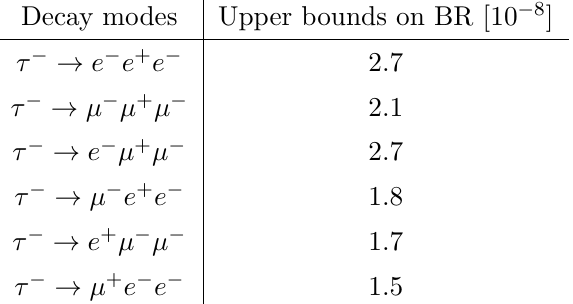
figure 4. For the kinematically allowed mass range, the constraints on BR ( τ → Xl about 1 . 4 × 10 − 4 for Scenario 1 and 2 . 6 × 10 − 3 for the second scenario. The corresponding upper limits on g are as strong as about 4 × 10 − 8 GeV − 1 and 2 × 10 − 7 GeV − 1 for the two τα scenarios, respectively, at the low mass regime. After the limits described in section